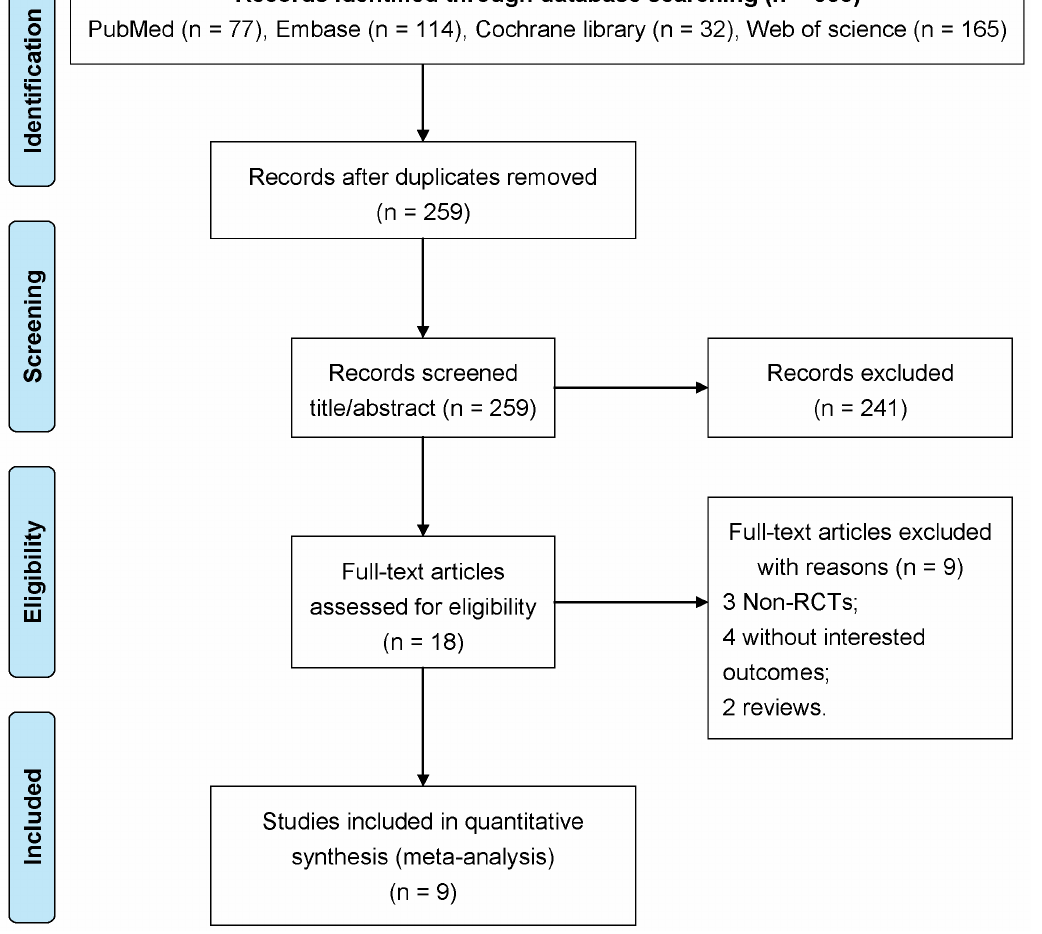
Figure 1. The detailed flow chart for study selection.